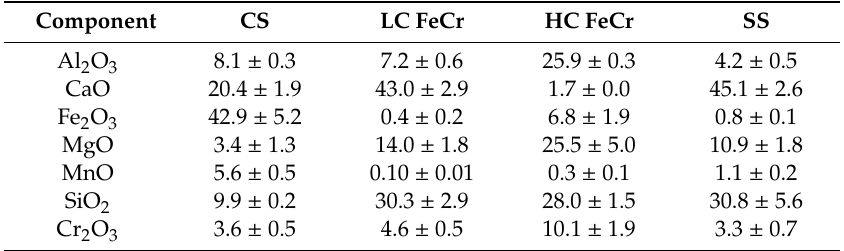
Table 1. Main components (average ± standard deviation, in wt %, as measured by X-ray fluorescence (XRF)